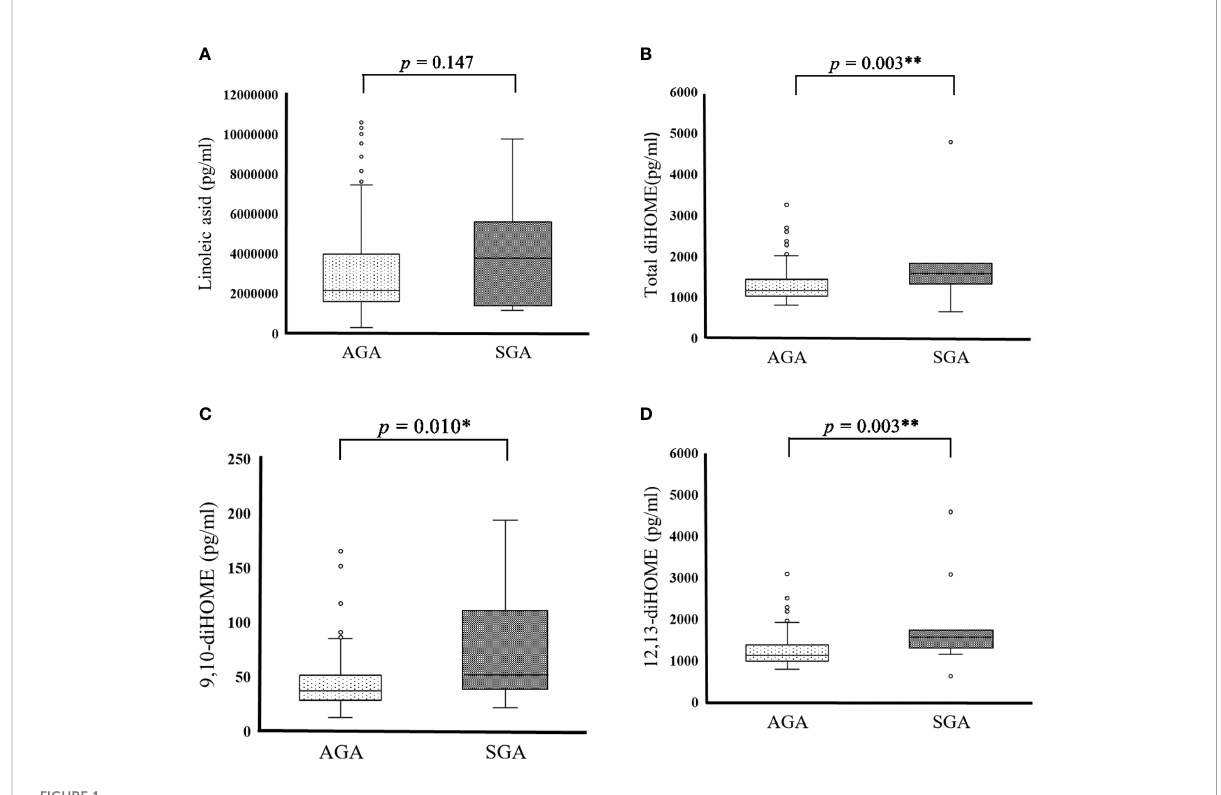
FIGURE 1 Cord blood PUFA metabolite in SGA and AGA infants. (A) Cord blood linoleic acid in AGA (2051991.877 ± 951304.536pg/mL) and SGA (2500019.845 ± 1318855.948 pg/mL) participants. (B) Cord blood total diHOME in AGA (1,272.320 ± 377.317 pg/mL) and SGA (1,915.757 ± 1,129.687 pg/mL) male subjects. (C) Cord blood 9, 10-diHOME in AGA (42.814 ± 22.070) and SGA (73.348± 49.116 pg/mL) participants. (D) Cord blood 12, 13-diHOME in AGA (1,229.506 ± 357.116 pg/mL) and SGA (1,842.409 ± 1,083.126 pg/mL) participants. Data are represented as the mean (± SD). Asterisks indicate **P < 0.01, *P < 0.05, Mann – Whitney U test, AGA (n = 179) and SGA (n =